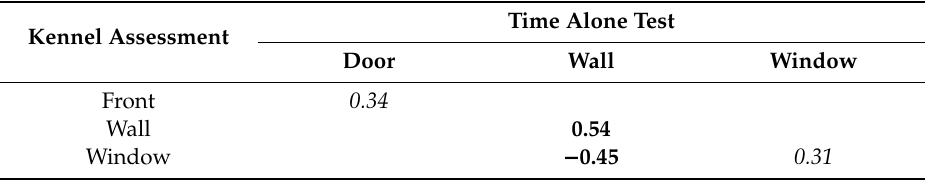
Table 10. Significant ( p < 0.05) Spearman Rank correlation coe ffi cients between locations recorded in kennel and the time alone test of shelter dogs ( n = 38).